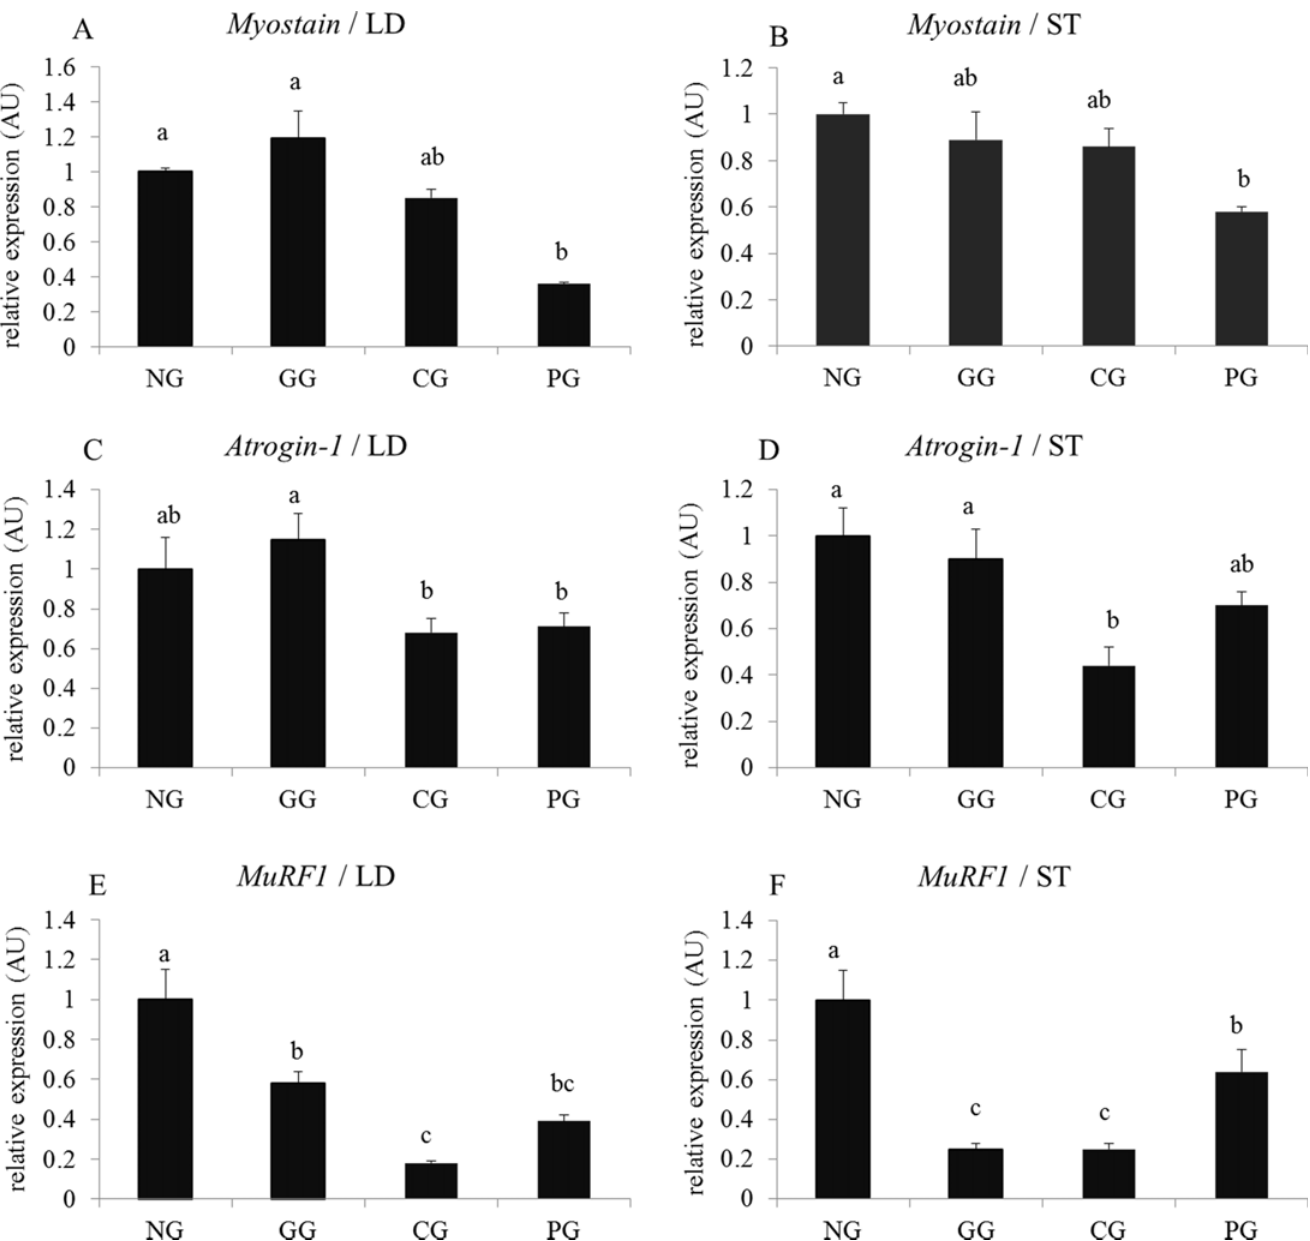
Fig 5. Effects of GHRP-2 and CS on genes relative expression of the protein degradation pathway in the LD and ST in yaks with growth retardation A, C and E are the relative expression of Myostain , Atrogin-1 and MuRF1 mRNA in the Longissimus dorsi (LD), respectively; B, D and F are the relative expression of Myostain , Atrogin-1 and MuRF1 mRNA in the semitendinosus (ST), respectively; NG: negative control group (yaks with growth retardation being fed basic rations); GG: GHRP-2 injection group (yaks with growth retardation being fed basic rations and GHRP-2 injection on days 1 – 6, 11 – 16, and 21 – 26); CG: CS feeding group (yaks with growth retardation being fed basic rations and supplementary fed cysteamine on days 1 – 28); PG: positive control group (yaks with normal growth being fed basic rations); The bars with different small letter superscripts within the same graph are significant different ( P <